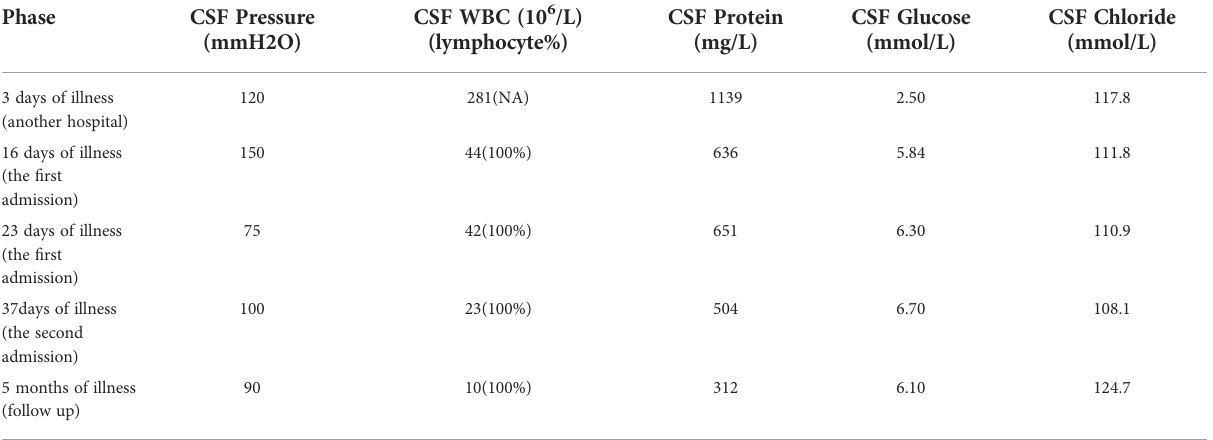
TABLE 1 CSF features of patients before and after